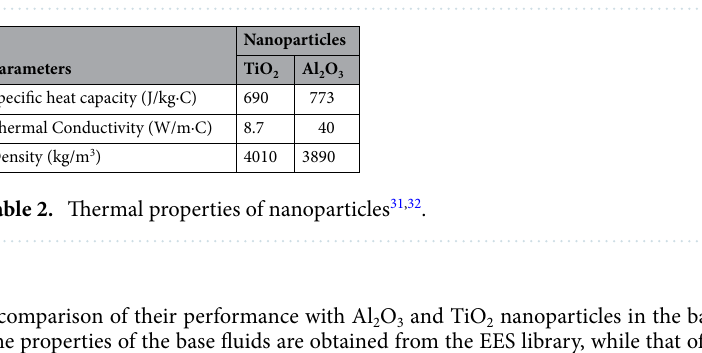
Figure 1. Schematic representation of the HVAC system.